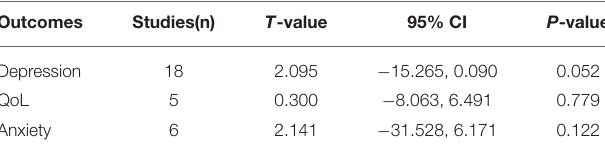
TABLE 4 | Egger’s regression analysis on publication bias of included